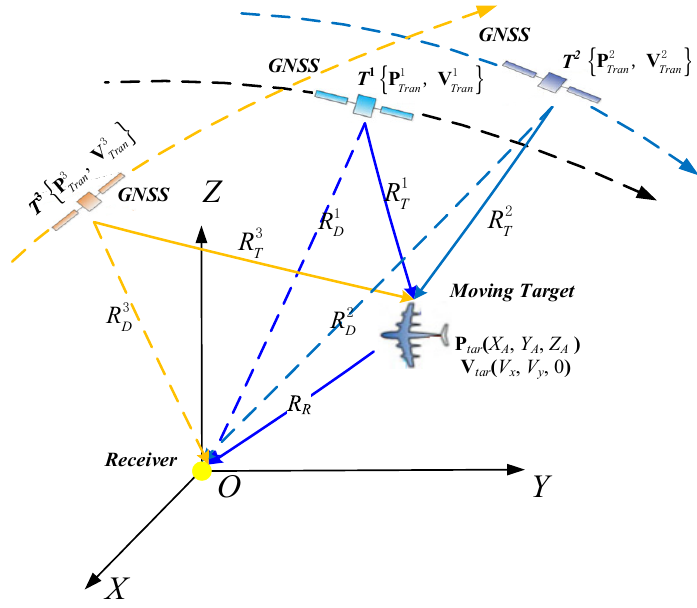
Figure 1. General geometric configuration of a multi-static global navigation satellite system based passive radar (MsGBPR) system.